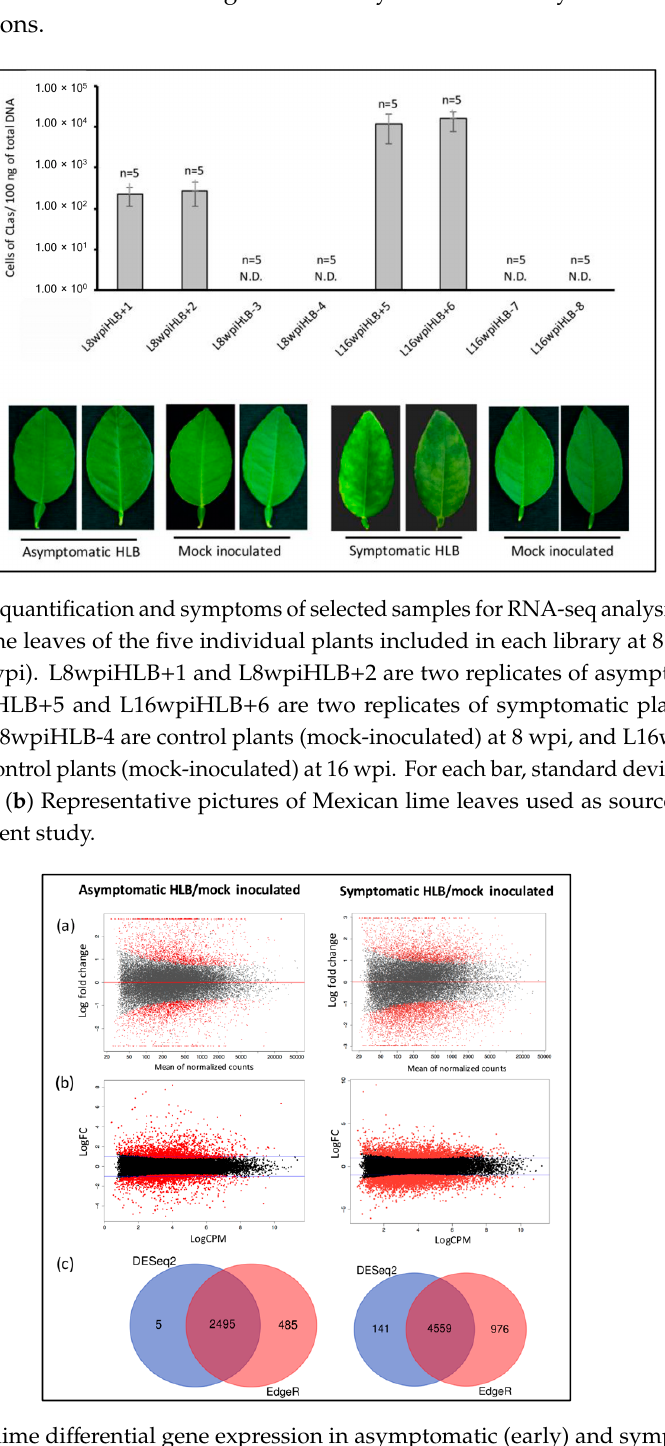
Figure 3. Mexican lime di ff erential gene expression in asymptomatic (early) and symptomatic (late) stages of Huanglongbing (HLB) disease. Log ratio versus abundance plots (MA-plot) for both infection stages using DESeq2 ( a ) and EdgeR ( b ) algorithm. ( c ) Venn diagram of di ff erentially expressed transcripts using both